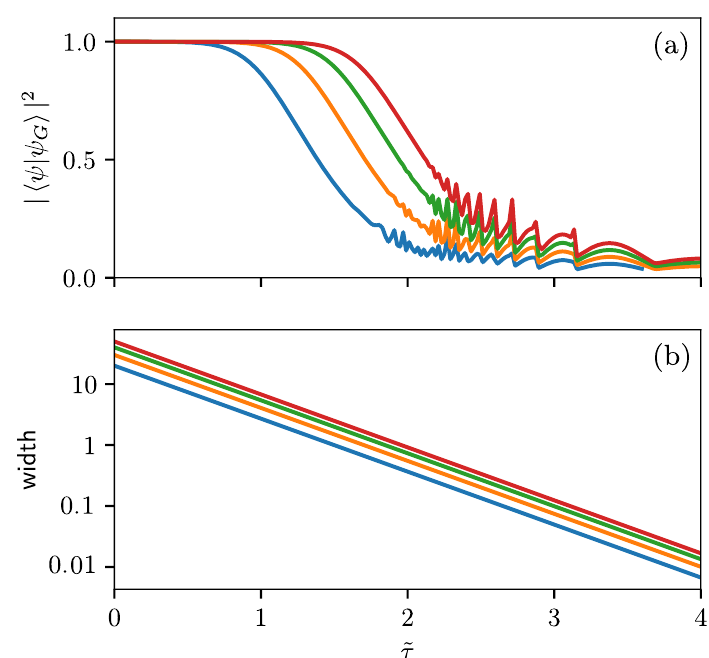
( τ ) and ψ ( τ ) and (b) the Figure 6: Time evolution of (a) the overlap between ψ G wave packet width for four different values of initial width. The drop in overlap ( τ ) becoming of the same order as the lattice coincides with the width of ψ G